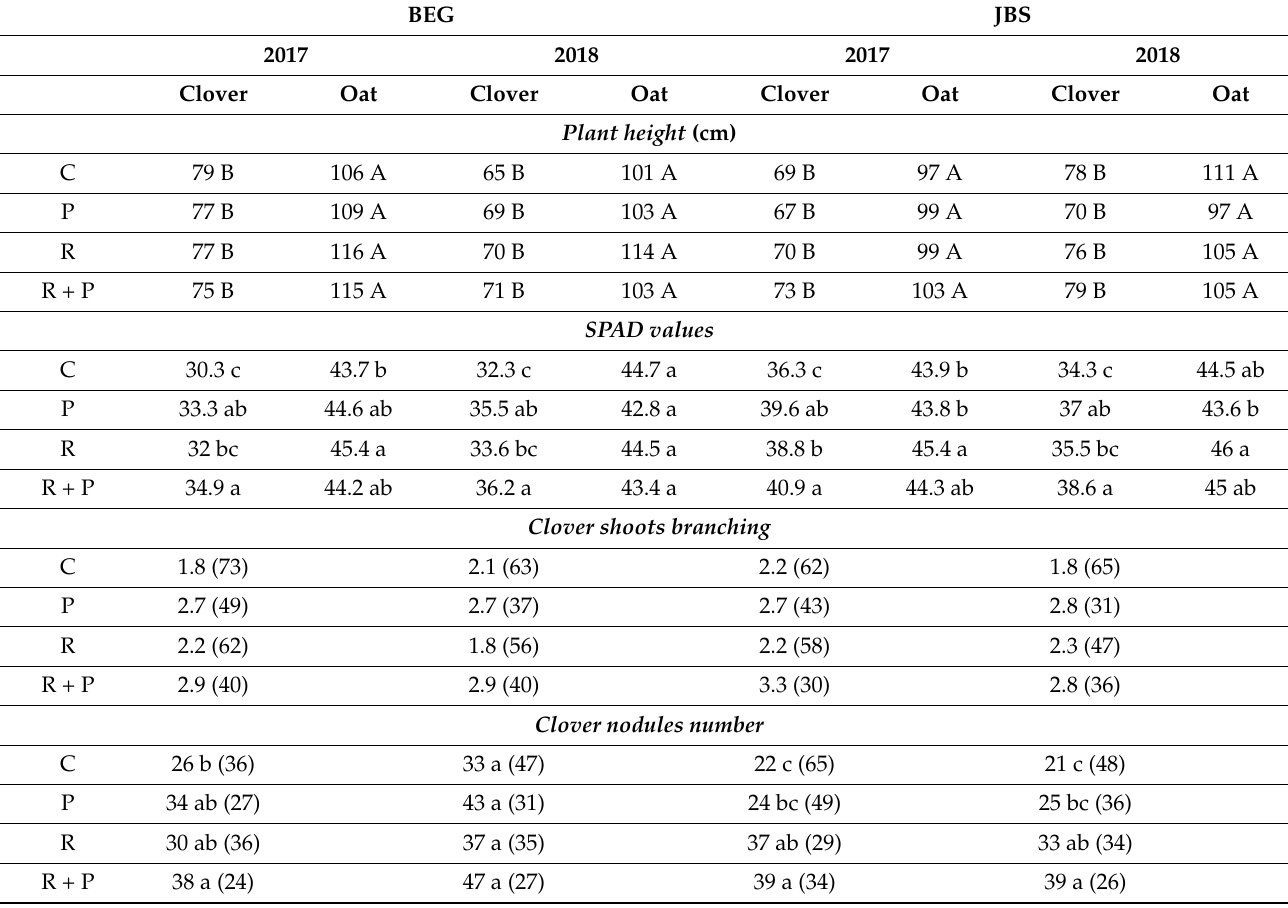
Table 2. Plant height, leaf SPAD values, number of branches, and nodules of clover and oats intercropped at the forage harvest date (150 DAS) at the BEG and SBR sites for both experimental